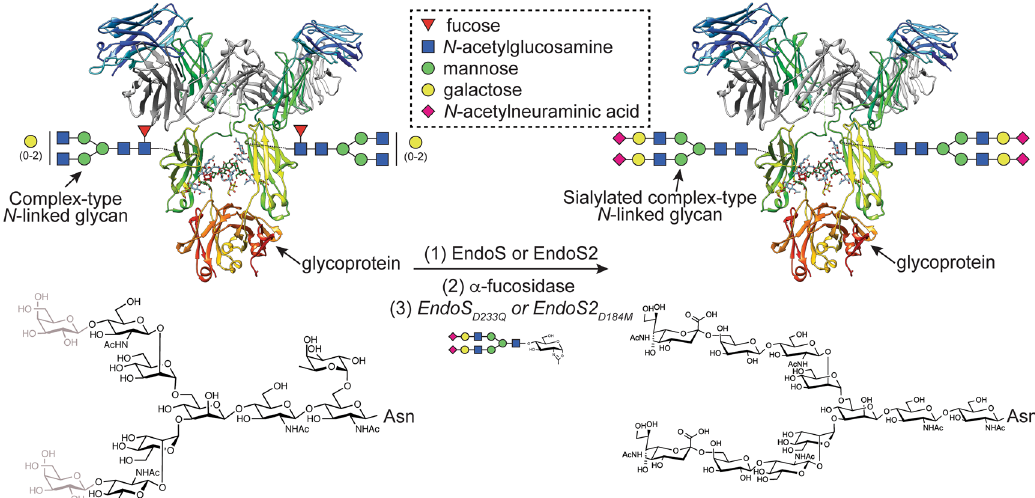
Fig. 1 IgG glycoengineering by ENGases. ENGases can be used to remodel the glycosylation pattern of IgG antibodies. In the fi rst step, an ENGase is used to cleave the variety of glycoforms present in the IgG antibody. In the second step, additional enzymes such as α -fucosidase can be used to remove speci fi c glycan moieties that are not cleaved by the ENGase. In the third step, a glycan-oxazoline donor is used along with an ENGase glycosynthase mutant in order to transfer a speci fi c glycan and obtain a homogeneously N -glycosylated IgG